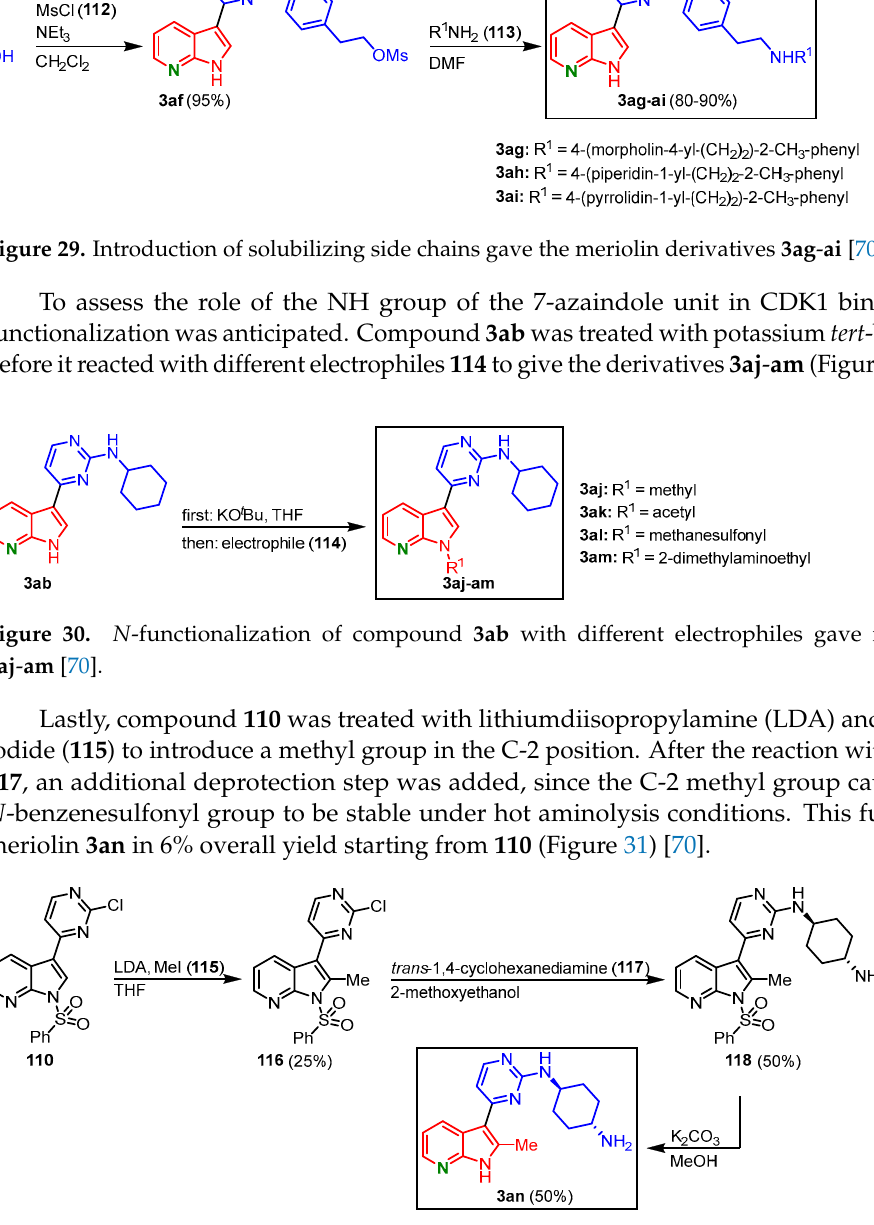
Figure 31. Synthesis of meriolin 3an [70].